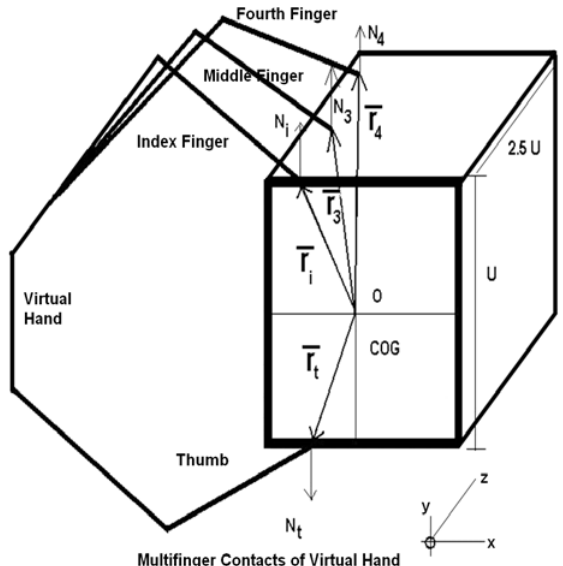
Figure 7. Virtual Grasp with Contact